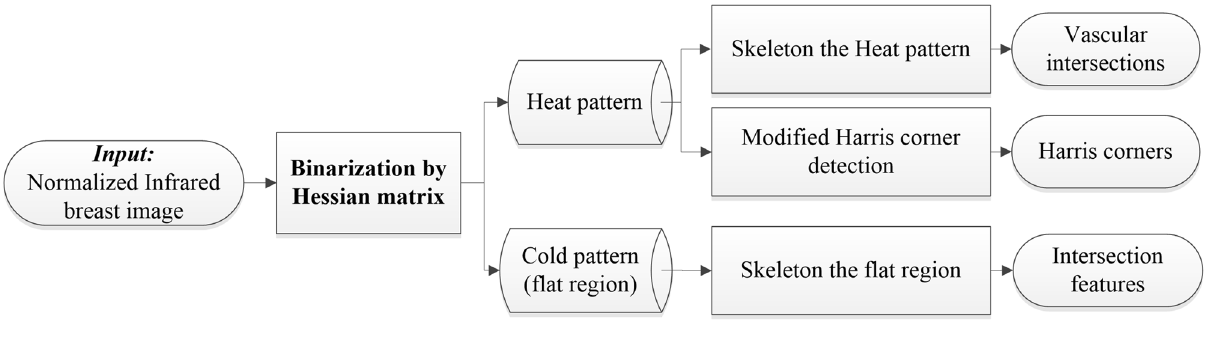
Figure 14. Flowchart of the feature detection